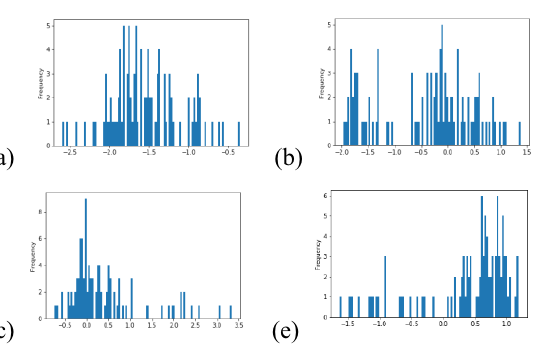
Figure 4. (a) Symmetric histogram, (b) Multimodal histogram, (c) Skewed-right histogram, and (d) Skewed- left